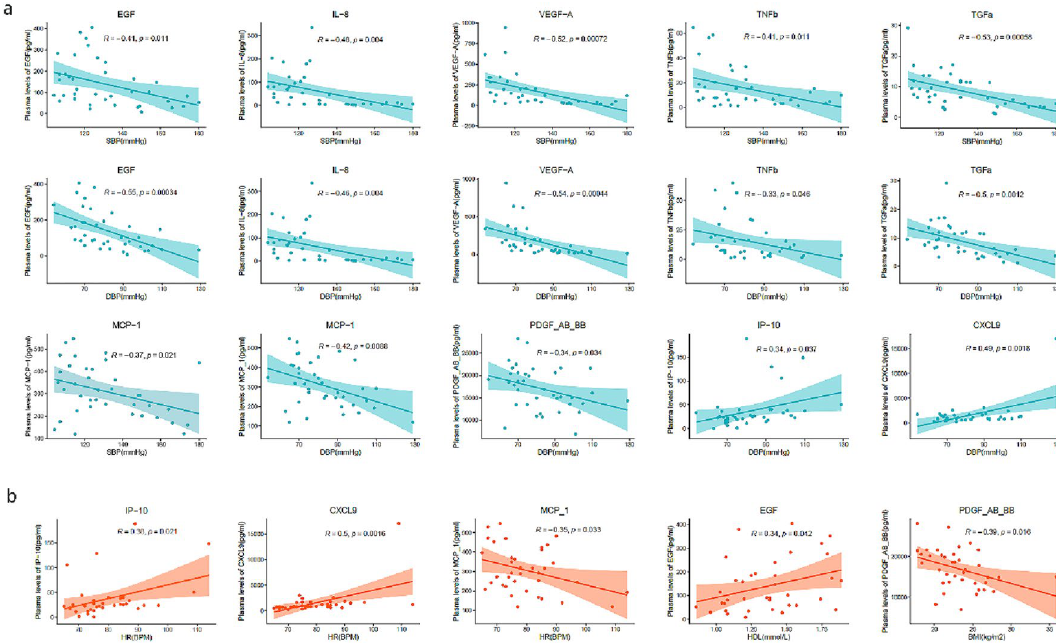
Figure 2. The correlation between the clinical indicators and some cytokines. ( a ) The correlation between the BP value and some significant cytokines. ( b ) The correlation between the HR, HDL, and BMI and the cytokines.